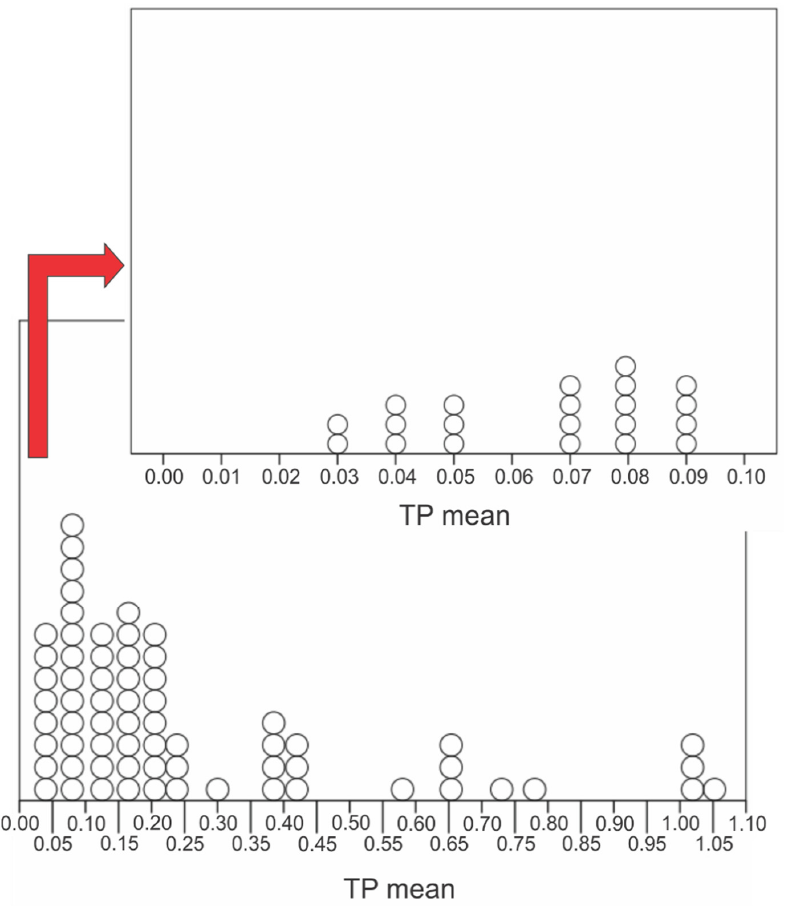
Figure 3. The distribution of the data within our dataset for the variable total phosphorous—annual mean (TP mean). Table 2. Total phosphorous gradient length given as the total phosphorous—annual mean (TP mean) and number of samples ( N ). The minimum value was, in all cases, 0.03 mg/L. TP Mean (mg/L)